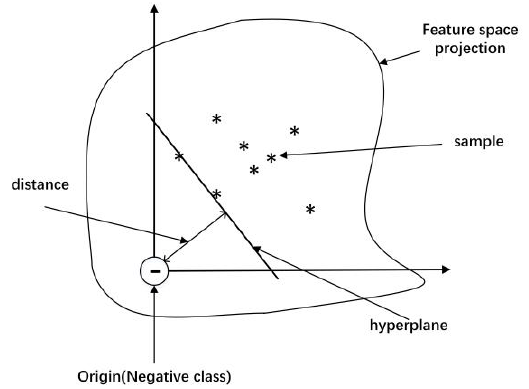
Figure 6. Schematic of the OCSVM.